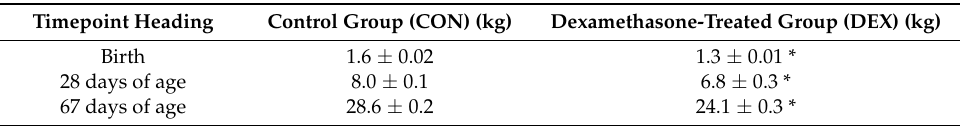
Table 1. Weight increase in controls (CON) and prenatally dexamethasone-treated pigs (DEX) over the first three months of